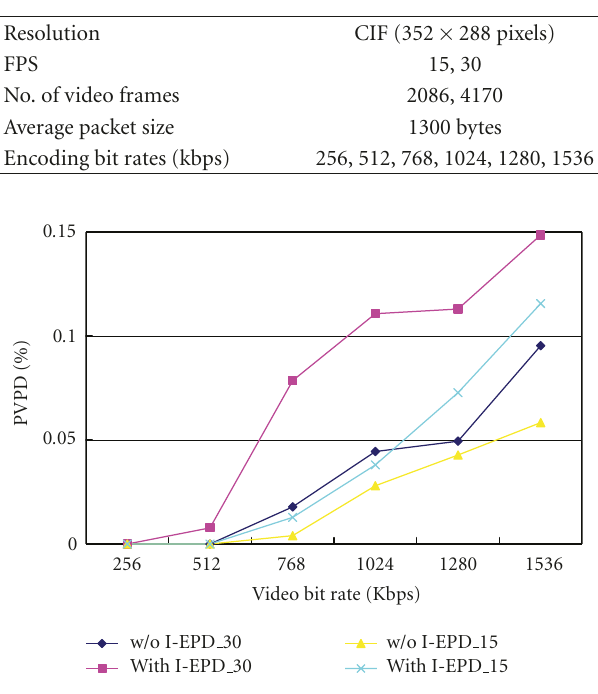
Figure 6: Percentage of received and useful frames (PRUFs).